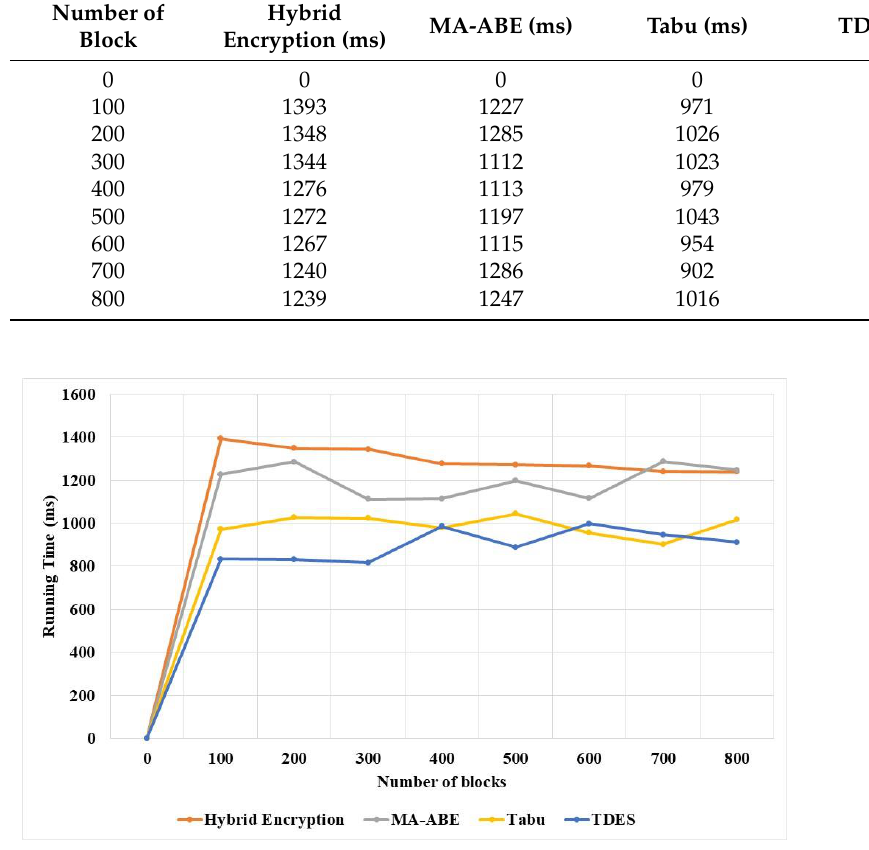
Figure 9. TDES and existing techniques running time for various number of blocks.